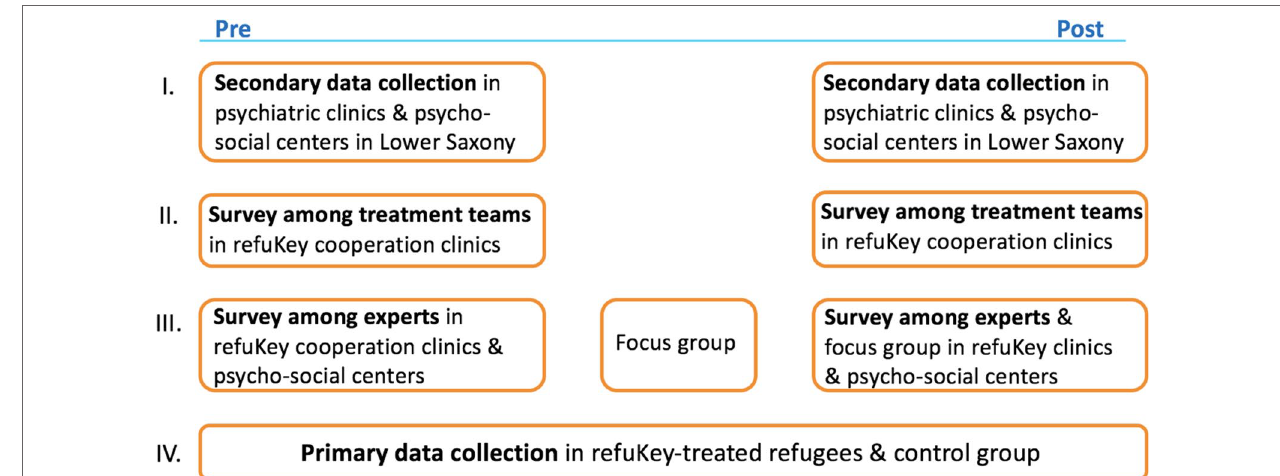
FIGURE 1 | RefuKey evaluation study